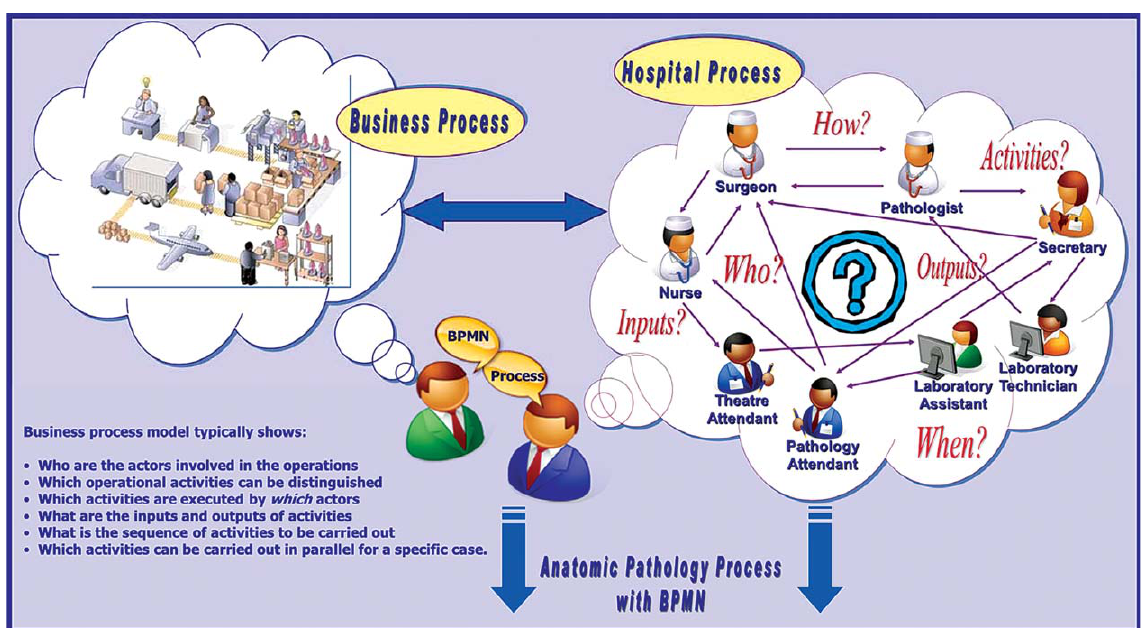
Fig. 2. Hospital processes can also be represented using a business process modelling